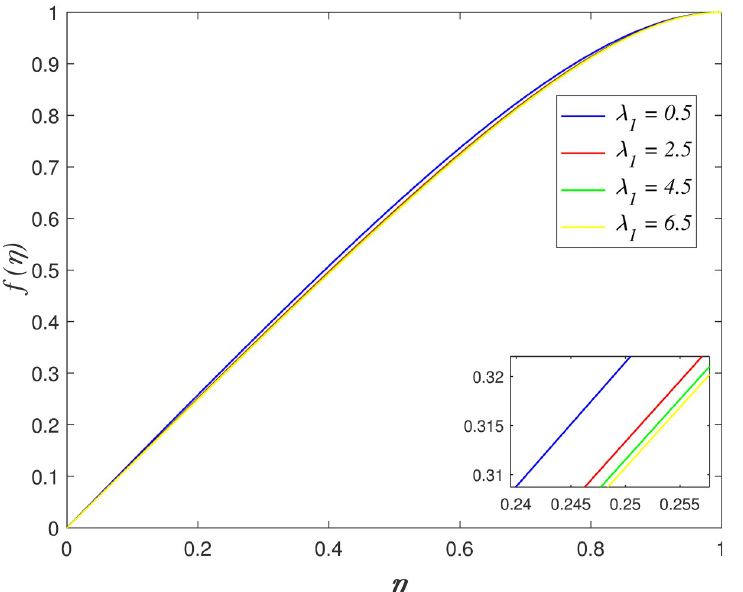
Fig 6. Impact of λ 1 on radial velocity.